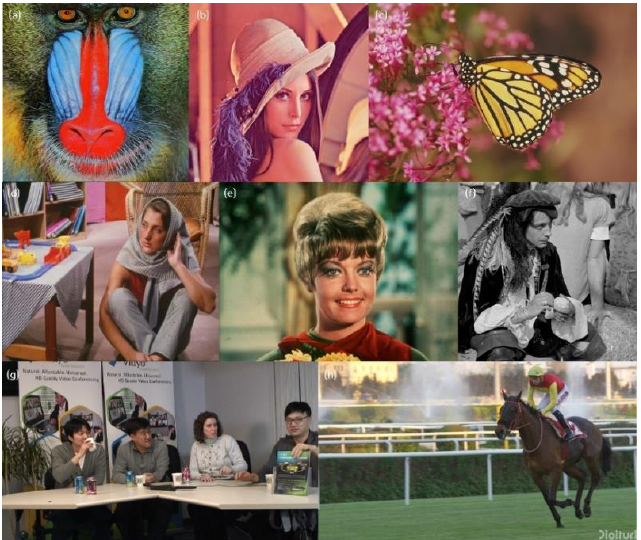
Figure 9. Still Images used for simulation. ( a ) Baboon (500 × 480), ( b ) Lenna (512 × 512), ( c ) Monarch (768 × 512), ( d ) Barbara (720 × 576), ( e ) Zelda (780 × 576), ( f ) Man (1024 × 1024), ( g ) Four people (1280 × 720), ( h ) Jockey (1920 × 1080).